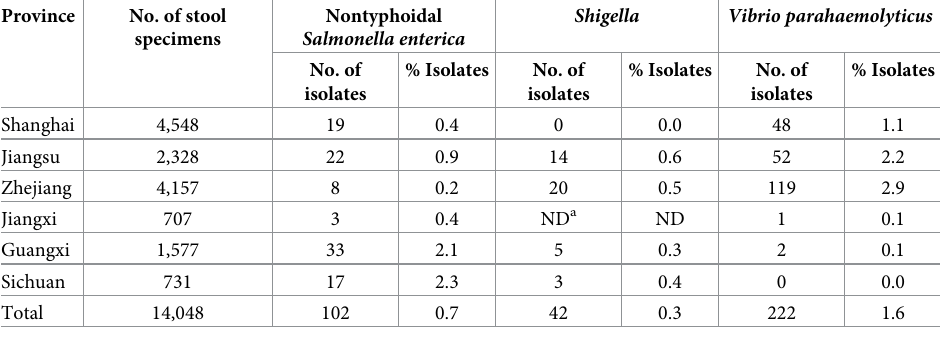
Table 2. Isolation rate of samples about nontyphoidal Salmonella enterica, Shigella and Vibrio parahaemolyticus in sentinel hospital of six provinces, China, 2010–2011. Province No. of stool Nontyphoidal Shigella specimens Salmonella enterica